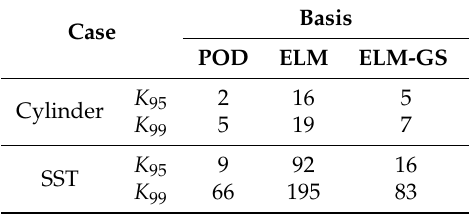
Table 1. Dimension estimation ( K 95 and K 99 ) for POD, ELM and ELM-GS corresponding to 95% and 99% energy using a POD reconstruction for both cylinder wake and sea surface temperature (SST)